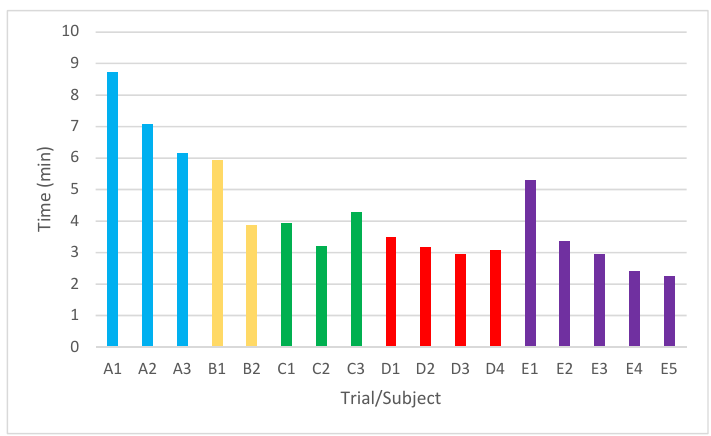
Figure 15. Evolution of the time to complete the task in each attempt of the five subjects.